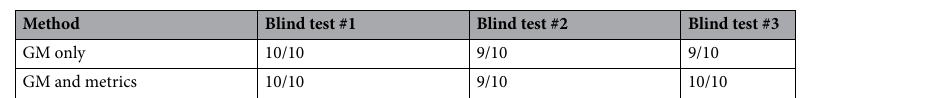
Table 1. Blind tests results. “GM only” signifies that the first indication of the present methodology was considered to be the match, while “GM and metrics” signifies that the first and second indication of the present methodology were supplementary examined